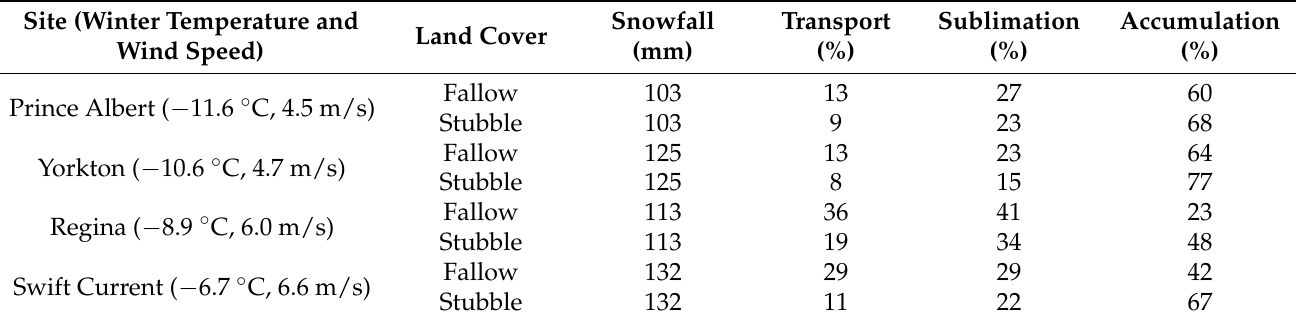
Table 3. Snow balance in fallow and stubble fields of 1 km length in Saskatchewan (adapted from [53,54]). The components of snow balance include snowfall in snow water equivalent, and blowing snow transport loss, sublimation loss and snow accumulation as percentages of